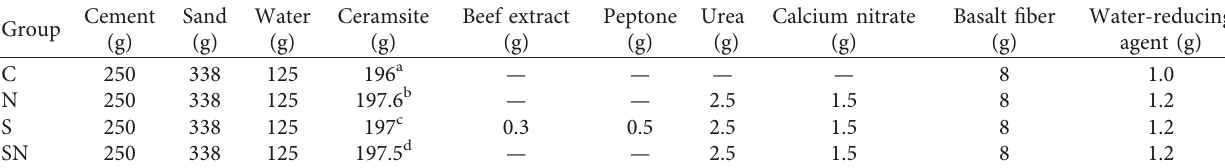
Table 1: The mixing